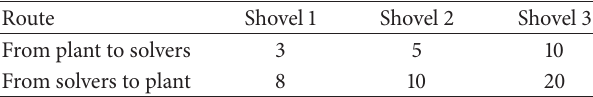
Table 1: Time (minutes) for mineral hauling.